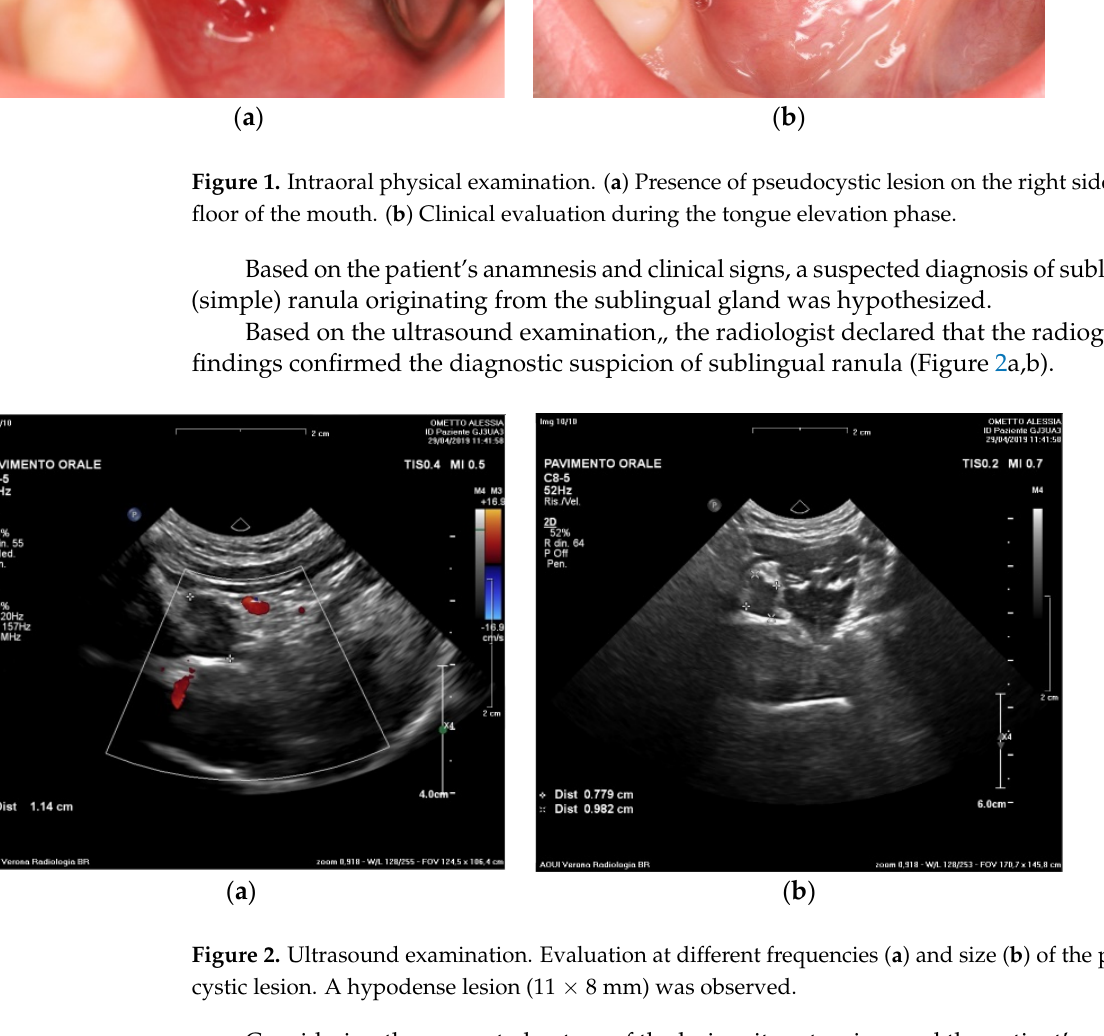
Figure 2. Ultrasound examination. Evaluation at different frequencies ( a ) and size ( b ) of the pseudocystic lesion. A hypodense lesion (11 × 8 mm) was observed.